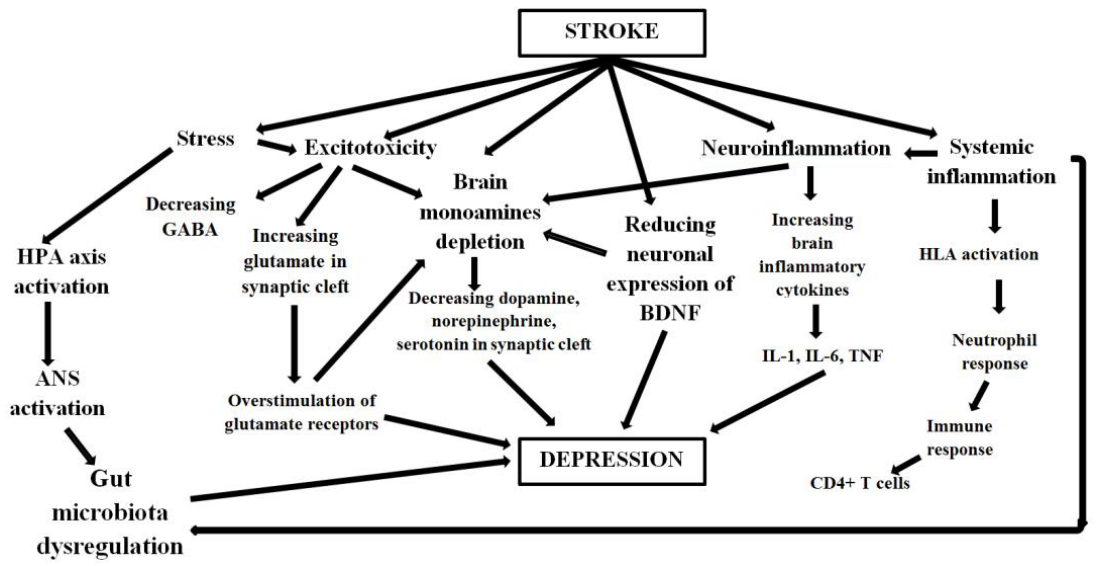
Figure 2. The complex pathogenesis of PSD including different molecular, inflammatory, and physiological mechanisms. (HPA — hypothalamic-pituitary-adrenal axis, ANS — autonomic nervous system, GABA — gamma amino-butyric acid, BDNF — brain-derived neurotrophic factor, HLA — human leukocyte antigen complex) .